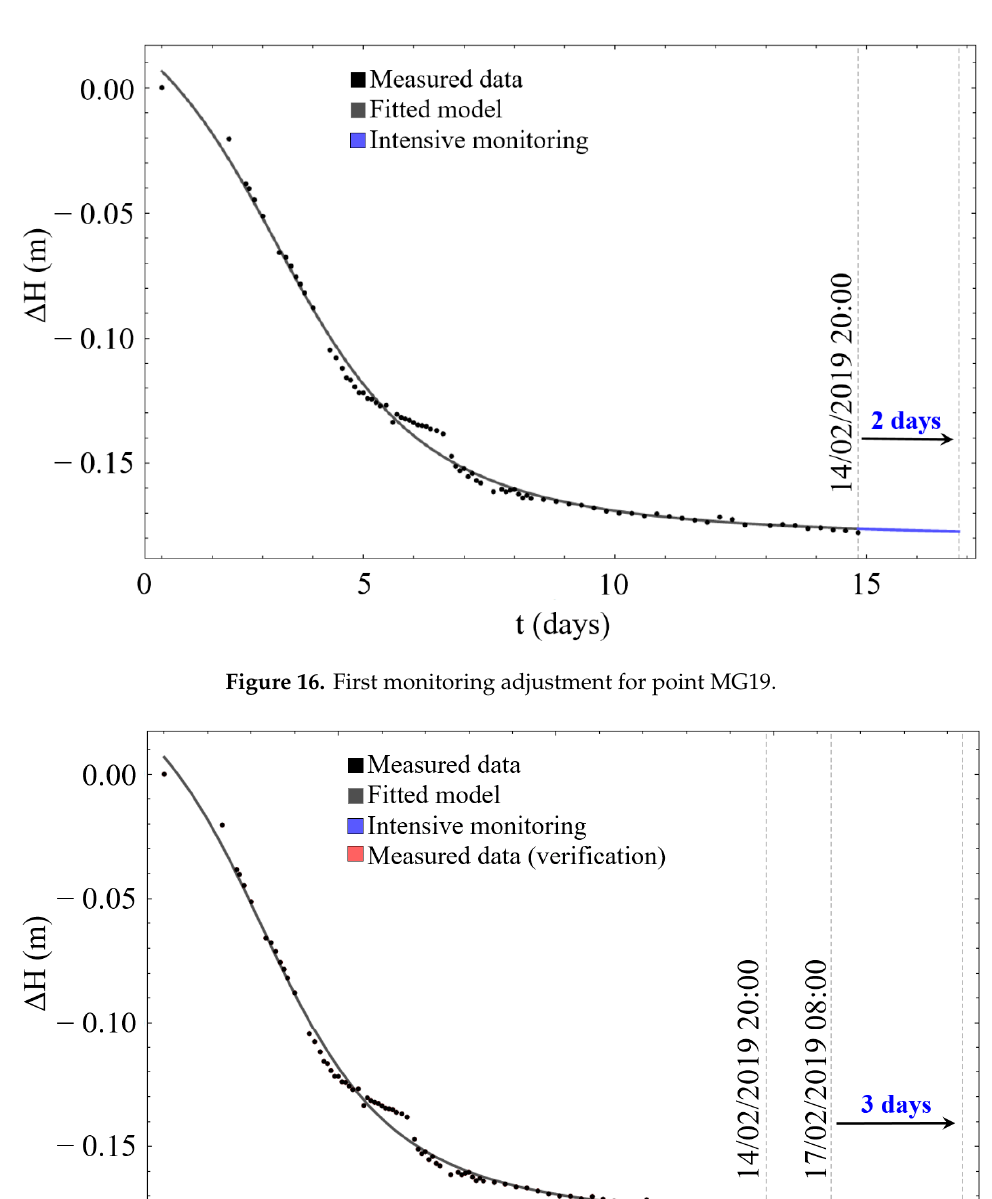
Figure 18. Third monitoring adjustment for point MG19. Monitoring adjustment was done until the end of the second reservoir filling, and then the final fitted model accuracy was again evaluated, as shown in Figure 19. Estimated parameter values are a → 0.1486, b → − 0.1925, s → 4.4234, p → 2.0066, and their standard deviations 0.0247, 0.0008, 0.1263 and 0.2957. The calculated variance and coefficient of determination are 33.0499×10 -6 and 0.9988. Future settlement prediction for point MG19 is shown in Figure 20. With the fitted FNSE model (color red) prediction of future settlement was made until 19/05/2019, and the estimated values were verified with actual settlement values (color blue).